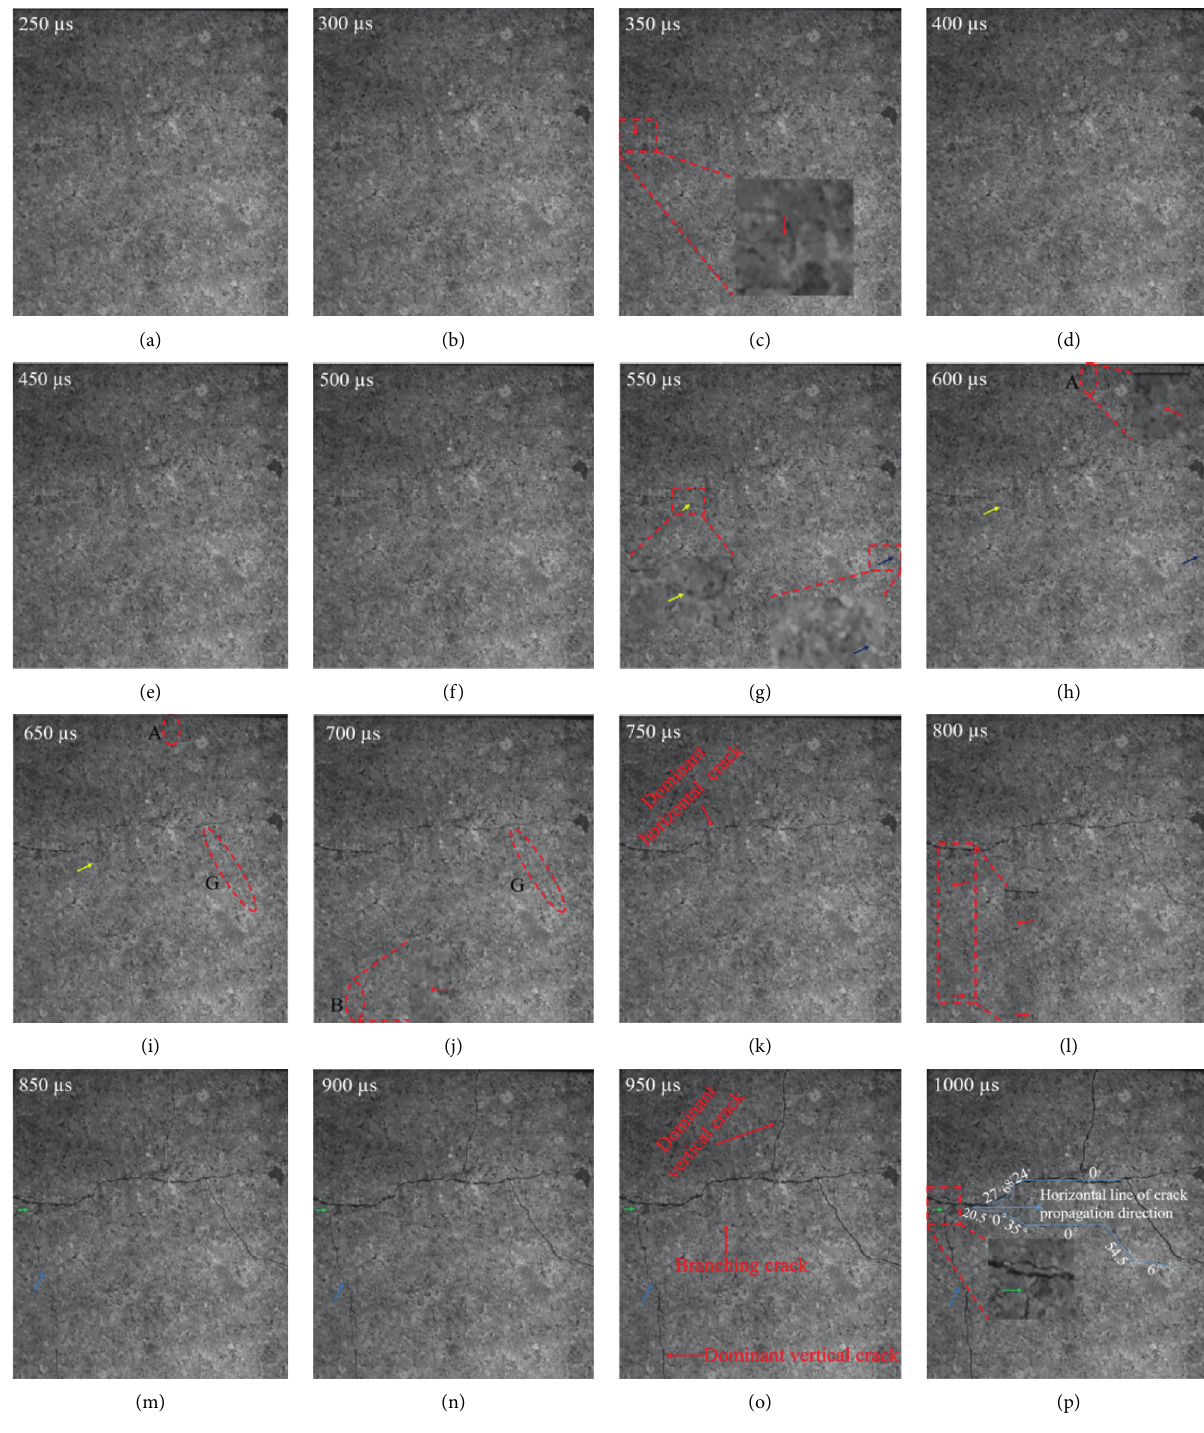
Figure 6: The crack evolution for test 1 (the magnification of the enlarged part is 300%). (a) 250 μ s. (b) 300 μ s. (c) 350 μ s. (d) 400 μ s.